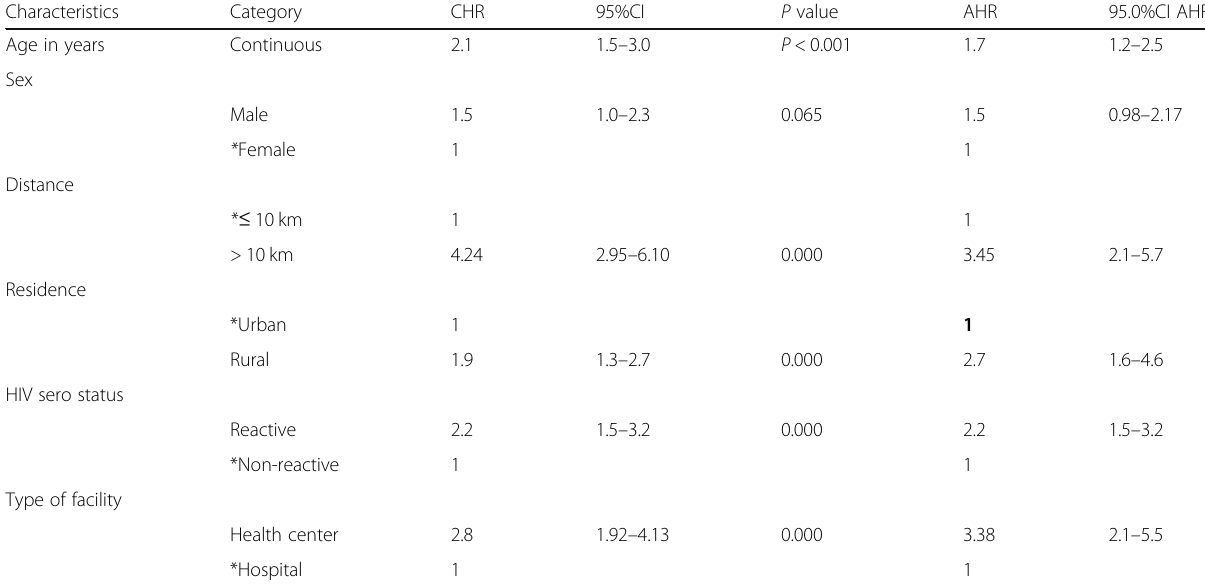
Table 4 Bivariate and multivariable cox regression hazard model at public health facilities, rural Ethiopia, during 2008 – 2015